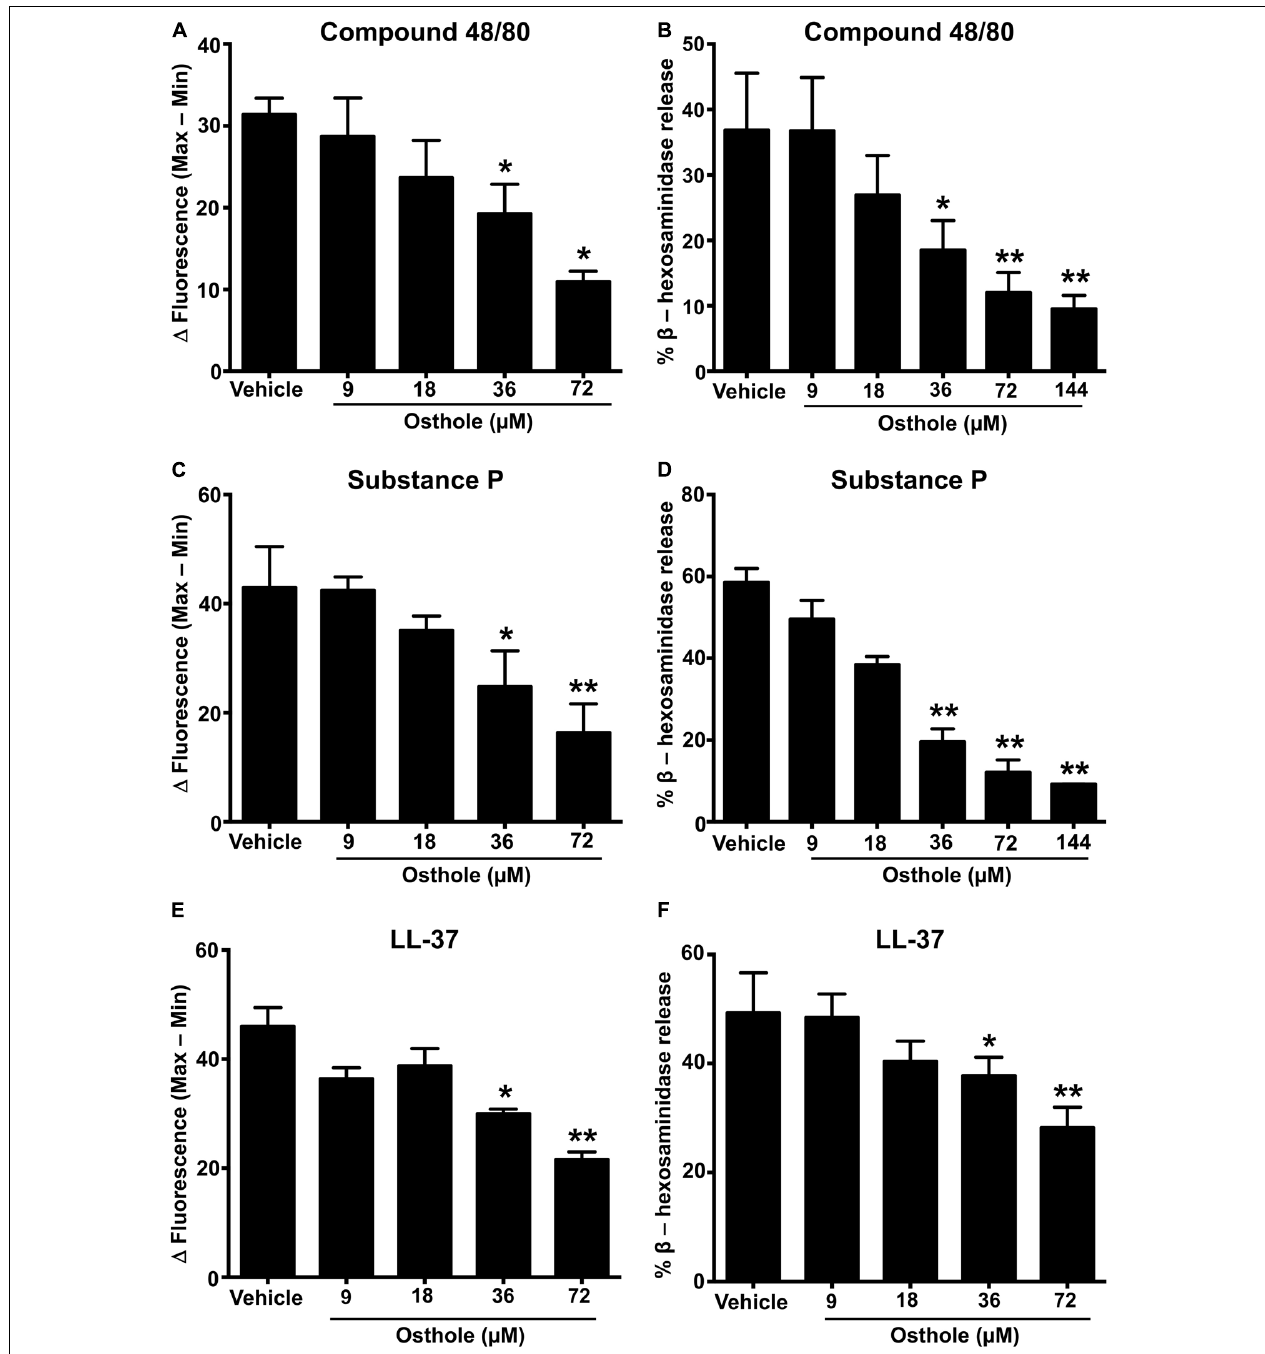
FIGURE 1 | Osthole inhibits MRGPRX2-induced Ca 2 + mobilization and degranulation in LAD2 mast cells. (A,C,E) Intracellular Ca 2 + mobilization and (B,D,F) degranulation in LAD2 human mast cells was determined following pre-incubation with vehicle (0.2% DMSO in PBS) or varying concentrations of osthole for 30 min. Cells were stimulated with the MRGPRX2 agonist (A) compound 48/80 (100 ng/ml), (C) substance P (300 nM) or (E) LL-37 (3 µ M) and changes in fluorescence intensities were recorded for 90 s. Data are plotted as the change in fluorescence intensity [minimum (Min) subtracted from maximum (Max) value] measurements. Vehicle- or osthole-treated cells were exposed to (B) compound 48/80, (D) substance P or (E) LL-37 and degranulation was quantified by β -hexosaminidase release. Values are plotted as percentages of total cell lysate β -hexosaminidase content. Data shown are mean ± SE of three independent experiments. Statistical significance was determined by unpaired Student’s t -test with values compared between the osthole- and vehicle-treated groups * p < 0.05 and ** p < 0.01.